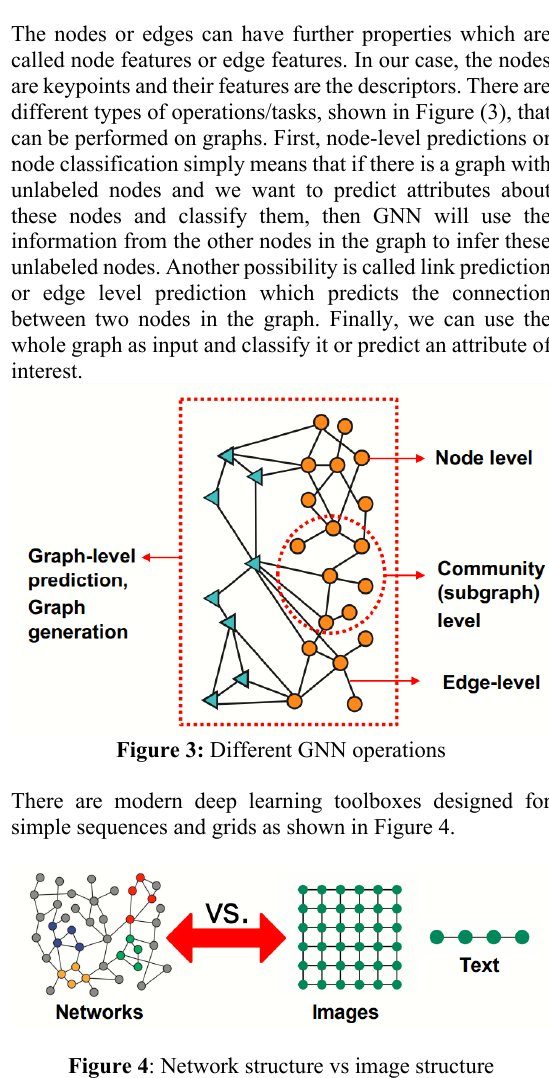
Figure 2 . Building the adjacency matrix